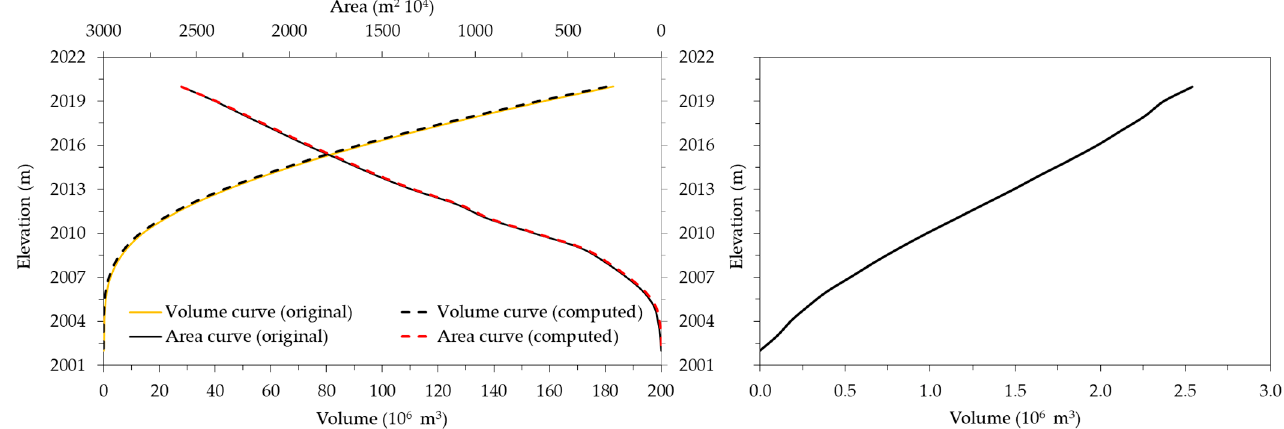
Figure 9. The original and adjusted stage-capacity and stag-earea curves for Koga reservoir (left) and reservoir sediment accumulation within fifty years design period of the dam (right).